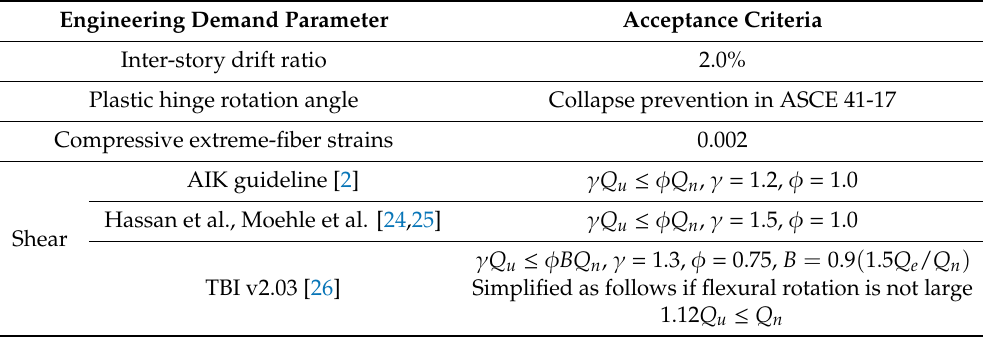
Table 4. Engineering demand parameters for performance-based seismic